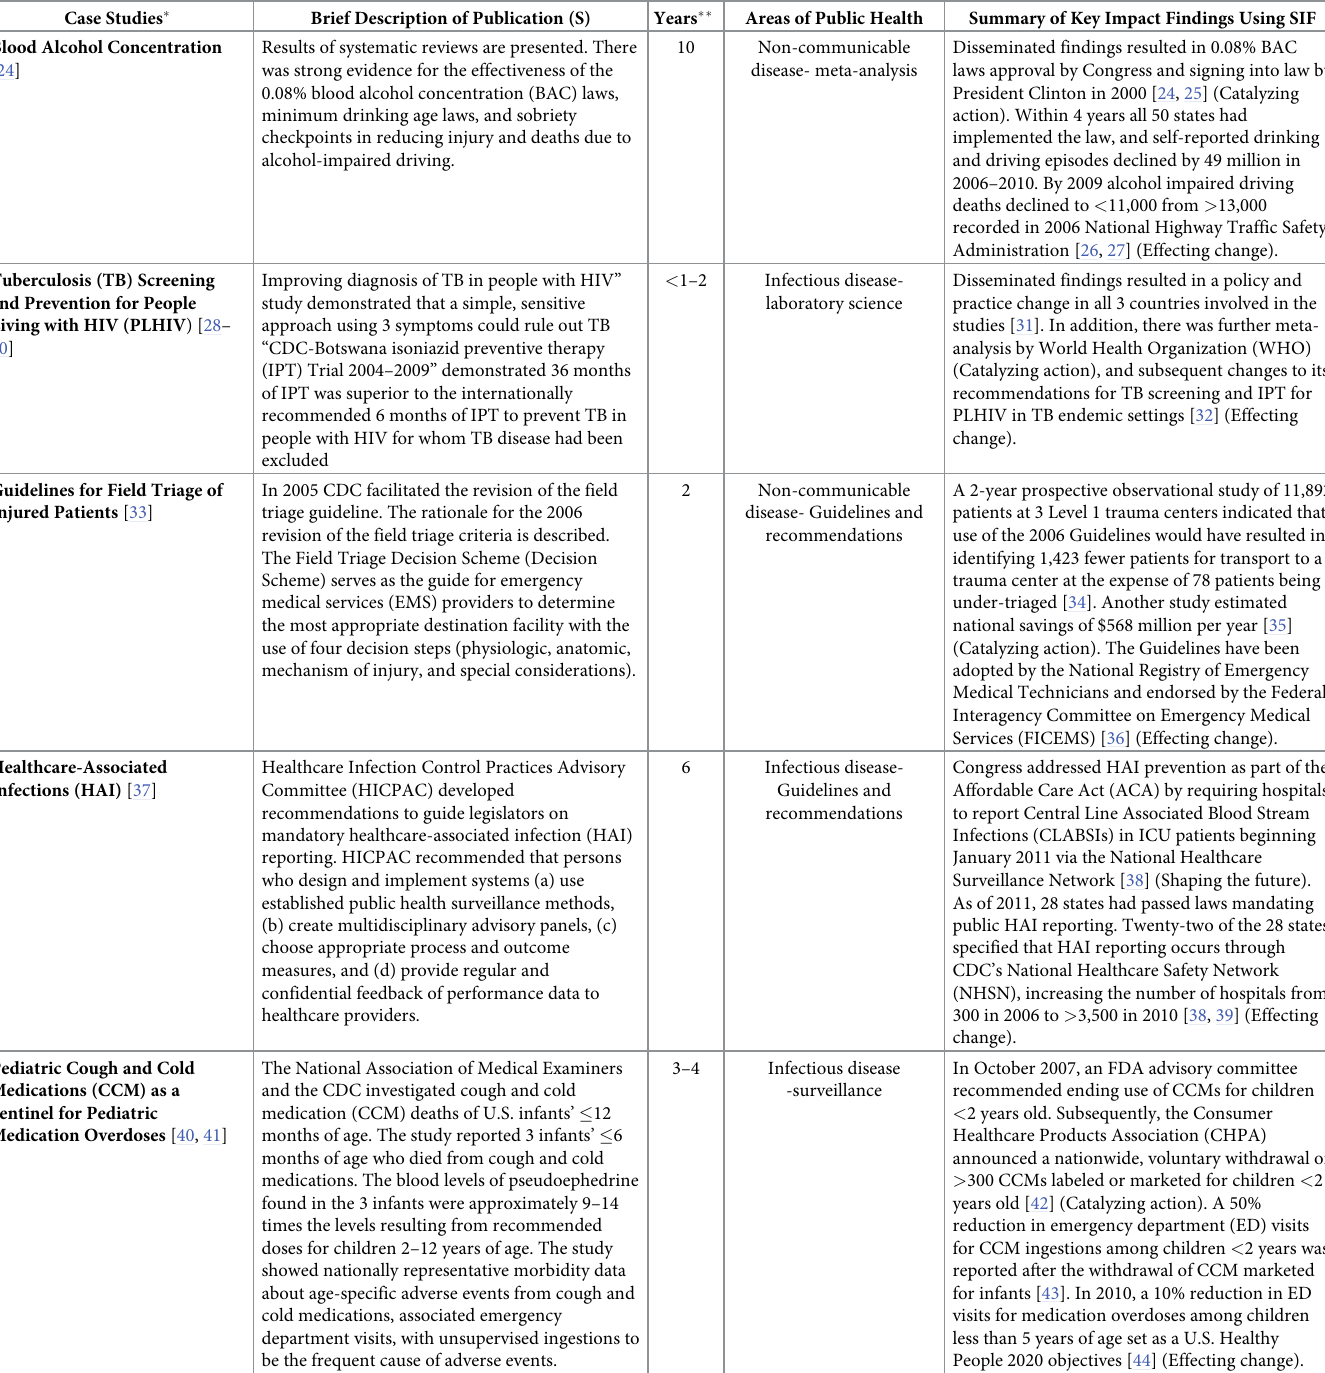
Table 3. Case studies used to validate the science impact